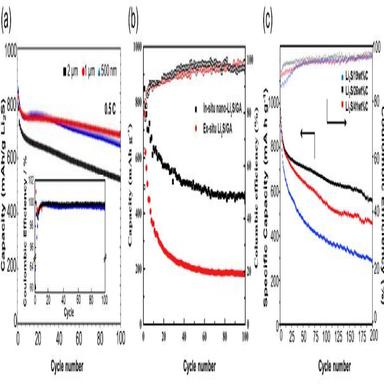
Electrochemical evaluations for Li-S batteries. (a) Cycling performances of the 2-lm, 1-lm, and 500-nm Li2S@C prepared by using with different amount of toluene particles at the 0.5C. (b) Comparisons of cycling performance at 0.1C of two composite electrodes (in-situ or ex-situ Li2S/GA) . (c) Cycling stability at 0.1C of the Li2S/C hybrids with different carbon content (19 wt% C, 26 wt% C, 41 wt% C). Reproduced from Refs. with permission from Royal Soc